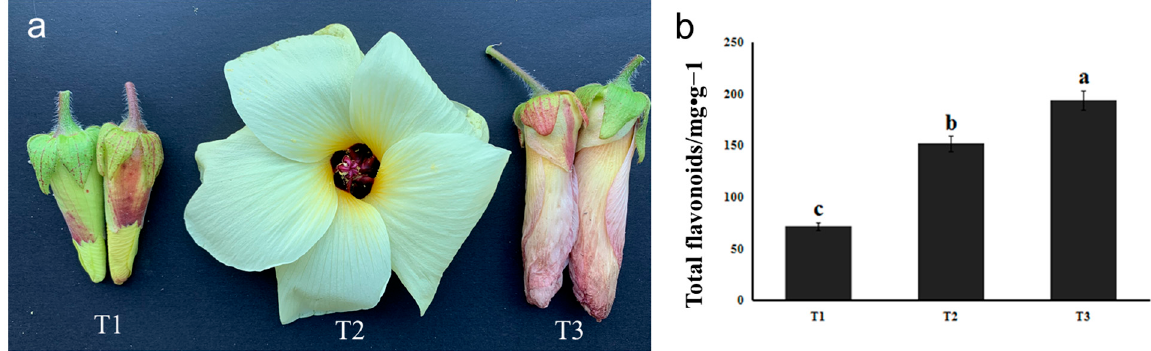
Figure 1. Phenotype ( a ) and total flavonoids measurement ( b ) in HSK at different flower development stages. The different letters (a, b, c) on the columns indicate the significance of the differences between each group, p < 0.05.